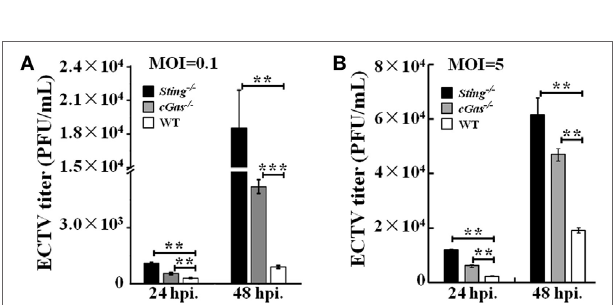
FigUre 6 | Sting and cGas restrict ectromelia virus (ECTV) replication in RAW264.7 cells. Sting − / − , cGas − / − , and wild-type (WT) cells were infected with ECTV at an MOI of 0.1 (a) or 5 (B) . After a 2-h incubation, the supernatants were replaced with fresh medium supplemented with 1% fetal bovine serum, and then the supernatants were collected at the indicated time points for viral titer measurements by using the plaque assay. All the data represent mean ± SD of biological triplicates from at least three independent experiments. The data were analyzed using a one-way analysis of variance followed by the Duncan’s multiple range test (** P ≤ 0.01 and *** P ≤ 0.001).